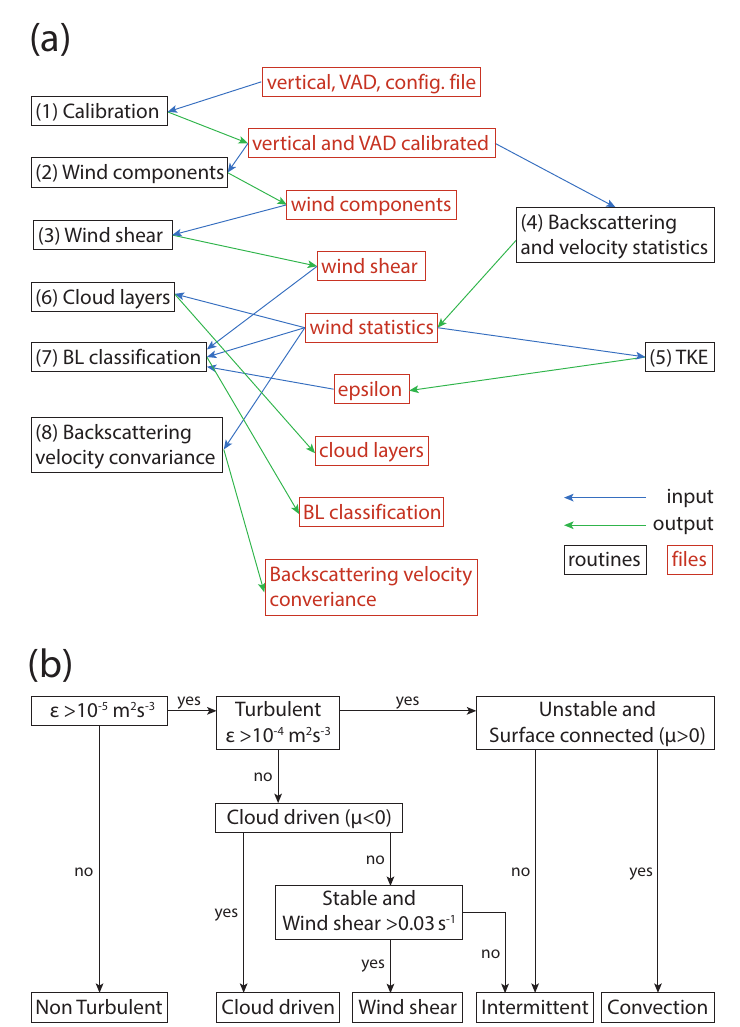
Figure 2. ( a ) Workflow of the Halo Toolbox and ( b ) the decision tree scheme for PBL